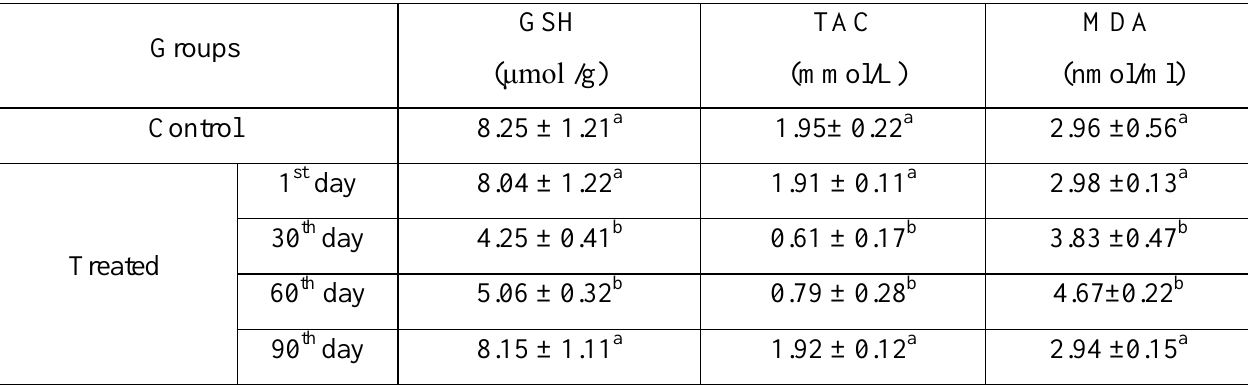
Table 2: IVM's effects on antioxidants and oxidant parameters in